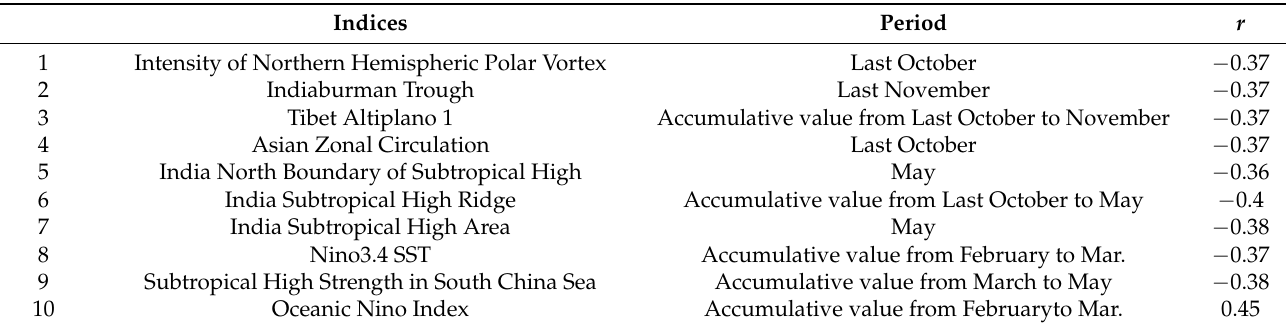
Table 3. Identified influencing factors of typhoon precipitation amount.